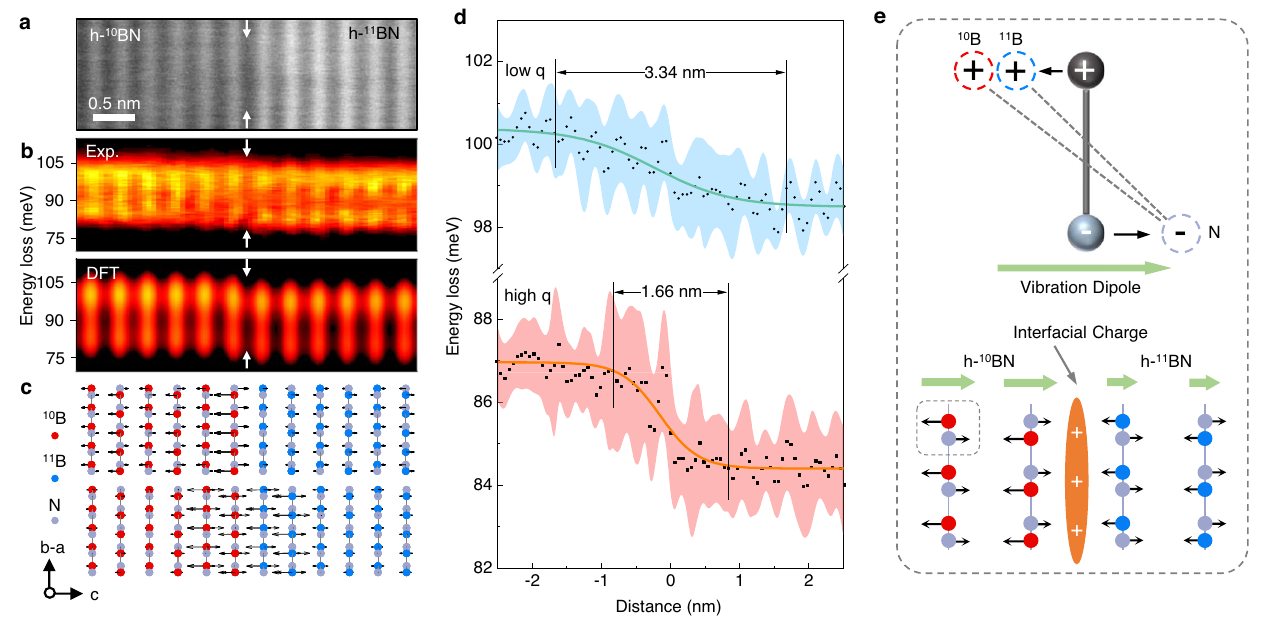
Fig.2|AtomicallyquantitativeanalysisofZOmodesath- 10 BN/h- 11 BNinterface. a HAADFimage ofh- 10 BN/h- 11 BNinterface. b ThecorrespondingexperimentalEELS obtainedatthesameregionof a ,andthecorresponding fi rst-principlescalculation results with the same experimental parameters. See analysis details in methods. c Spatial distribution of typical phonon modes around the h- 10 BN/h- 11 BN interface. ThearrowsareeigenvectorsextractedfromDFTcalculationscorrespondingtothe Brillouin Zone center (q= Γ , ω =102.5meV) and Brillouin Zone boundary (q=K, ω =71.2meV & ω =74.7meV), denoting the two out-of-plane vibrations in b . d Quantitative energy variation of the ZO modes. Theblack dots are fi tted phonon